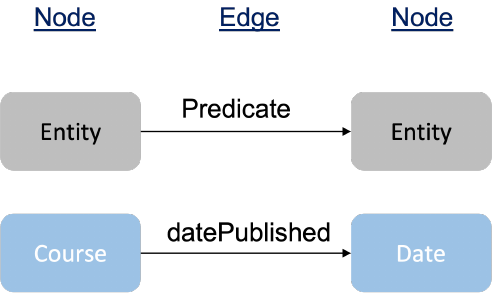
Figure 1. The structure of a Triple and an example of